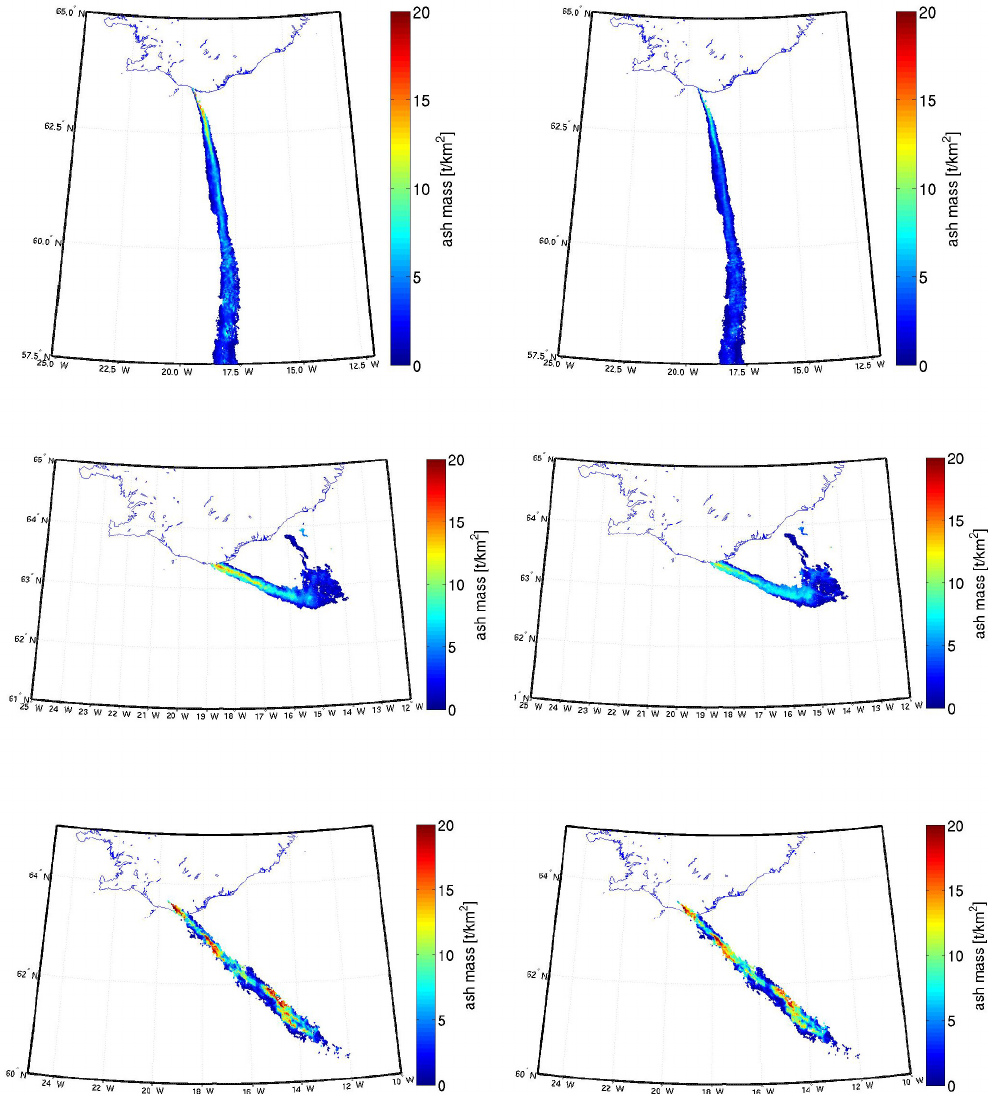
Figure 17. Ash mass maps: top, 11 May 2010; middle, 12 May 2010; bottom, 16 May 2010. Left: target retrieval; right: retrieval from pruned neural